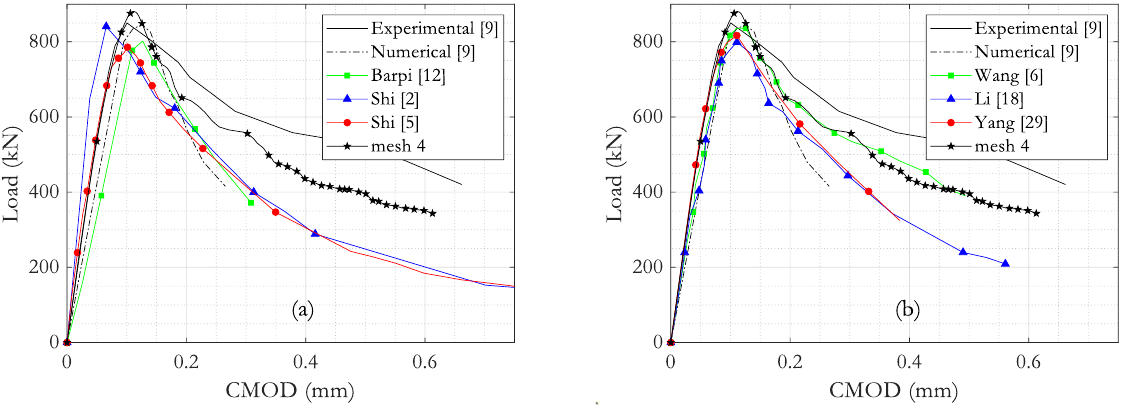
Figure 6. Load versus CMOD curves retrieved in the literature survey from: ( a ) data from 2000 to 2013, ( b ) data from 2015 to 2019; and comparison with the results for mesh 4 using the bilinear softening model provided by fib model code 2010 [32].